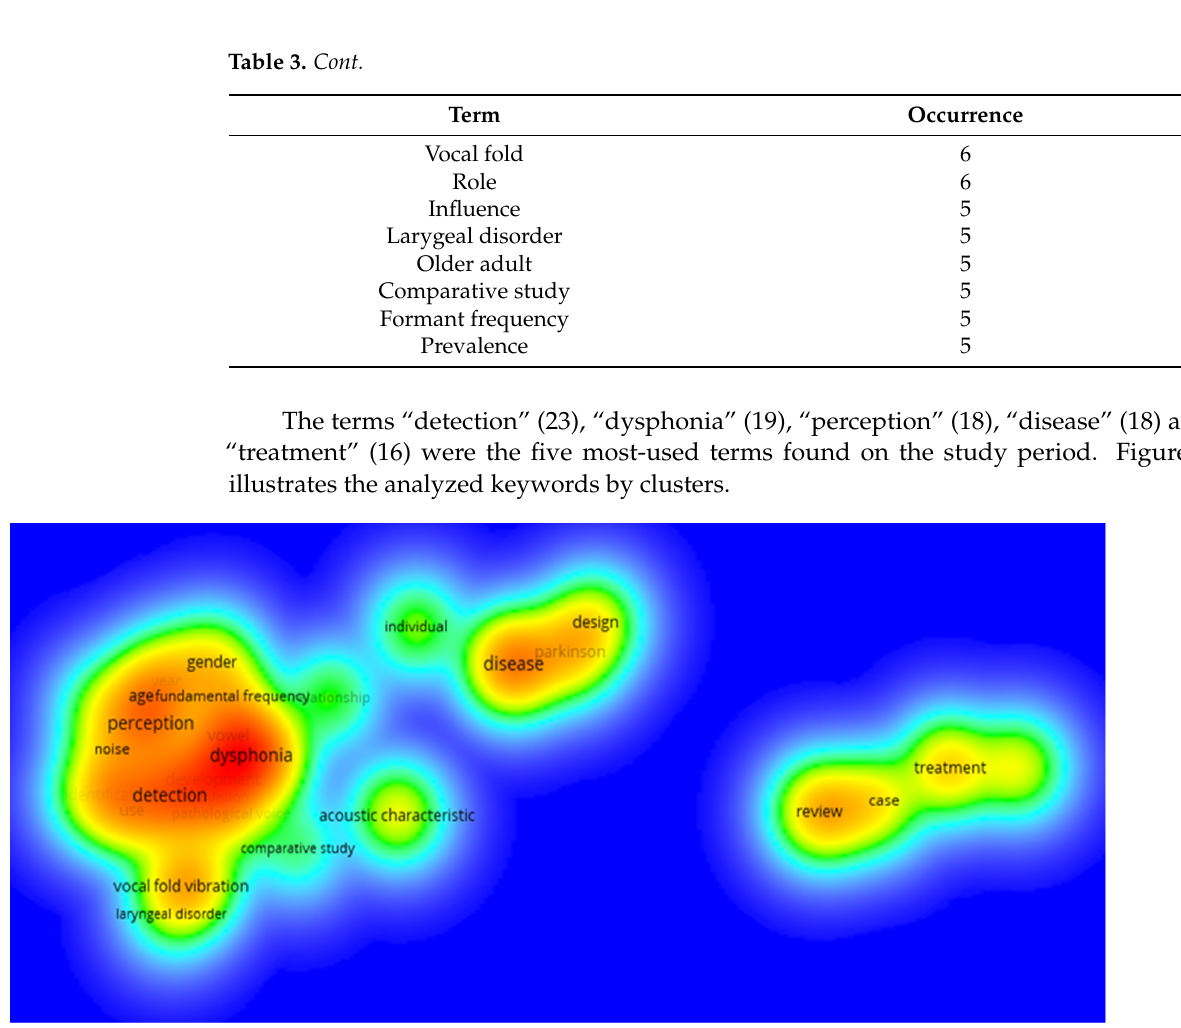
Figure 6. Most-used keywords (the redder color indicates a more frequent use, and the green color less frequent use). Based on data from the most common keywords, established by the aforementioned limits (the number of occurrences of each term was set at 5).